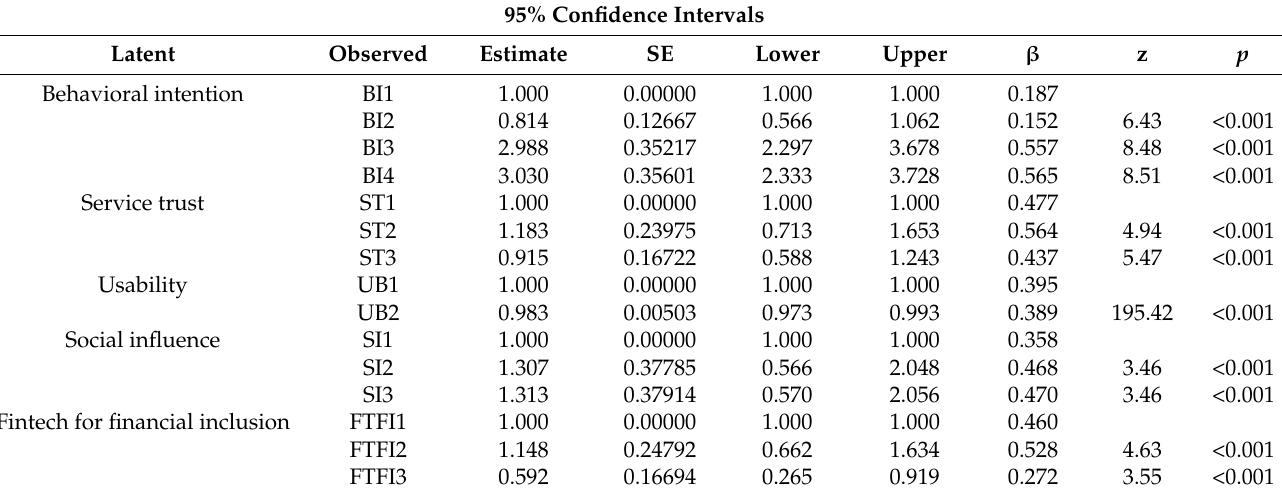
Table 5. Measurement model.